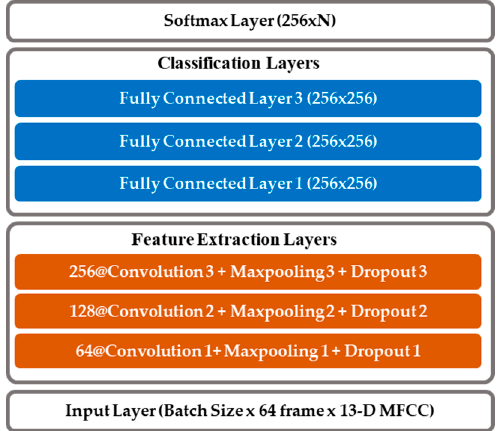
Figure A6. Establishing connection to UAV systems.